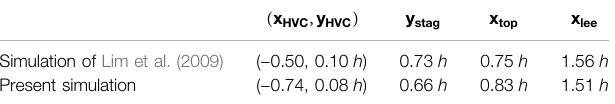
TABLE 2 | The locations of the center of the horseshoe vortex (HSV) ( x HVC , y HVC ) ; the stagnation point on the windward face y stag ; the fl ow reattachment